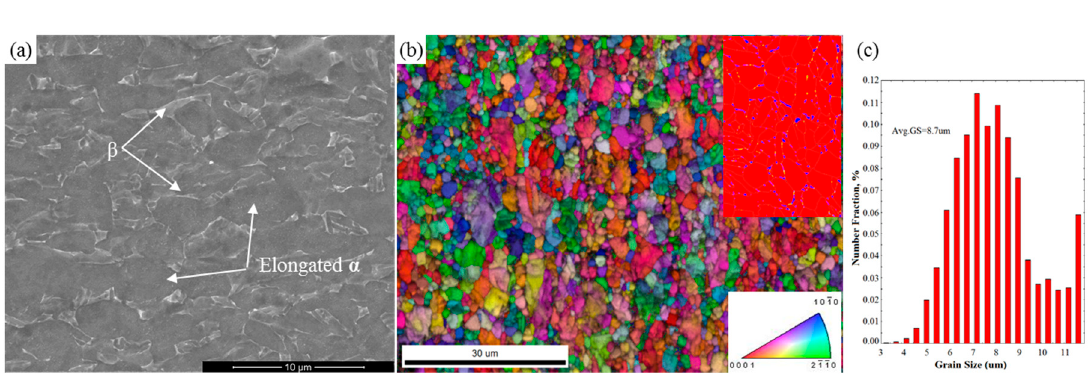
Figure 2. As-received Ti–6Al–4V alloy: ( a ) SEM image of microstructure, ( b ) electron backscattering diffraction (EBSD) image of inverse pole figure (IPF) map and phase map (with respect to TD), ( c ) distribution of grain size acquired using the EBSD.